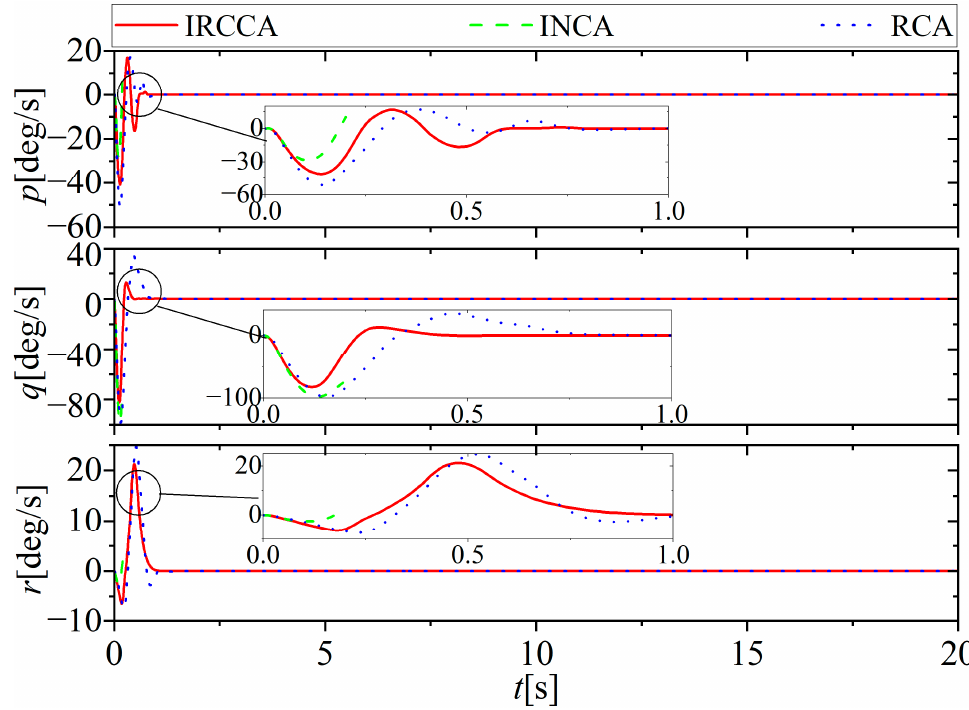
Figure 6. Time response of the attitude angle rate with lock-in-place fault.